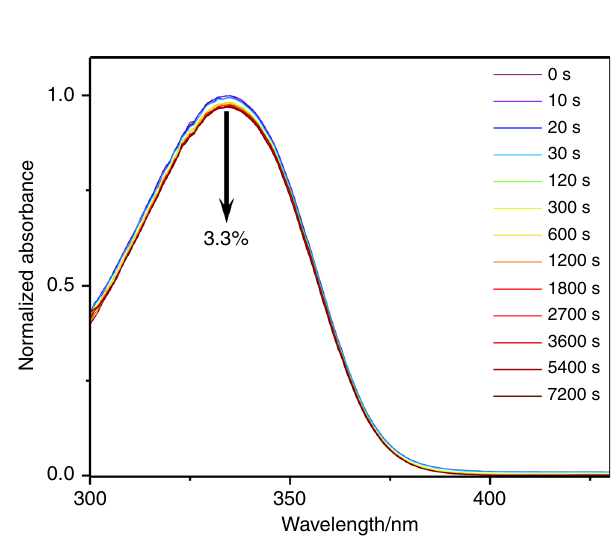
Fig. 3 Long-term photostability of DES. UV/visible spectra of DES in C12 – 15 alkyl benzoate (AB), at varying durations of irradiation at 335 nm and replicating solar intensity. The downwards arrow (in black) denotes the observed 3.3% decrease in absorbance after 7200 s of irradiation